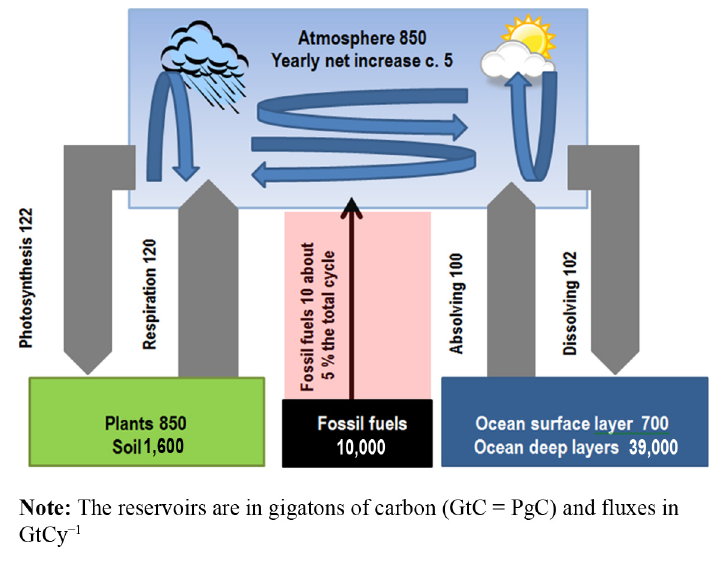
Figure 2. A simple carbon cycle presentation is based on the average values from literature